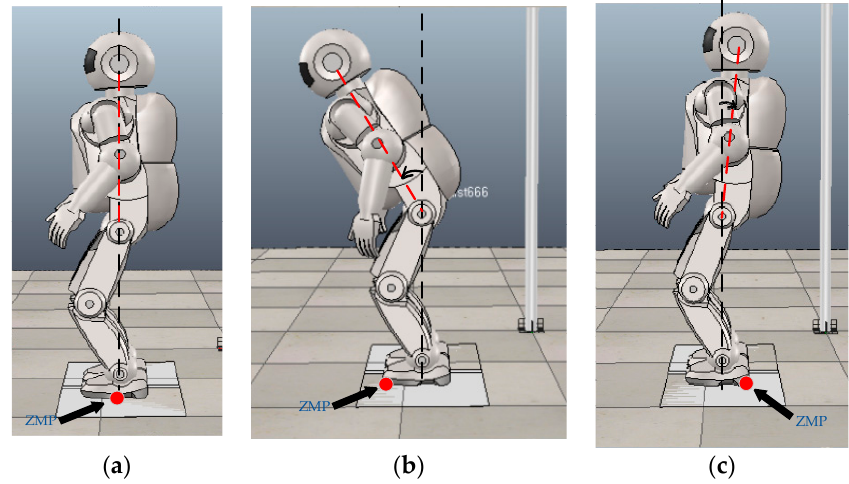
Figure 12. Zero moment point (ZMP) movement in the x-direction: ( a ) robot standing upright, ( b ) center of gravity of the robot moving forward and ( c ) center of gravity of the robot moving back.